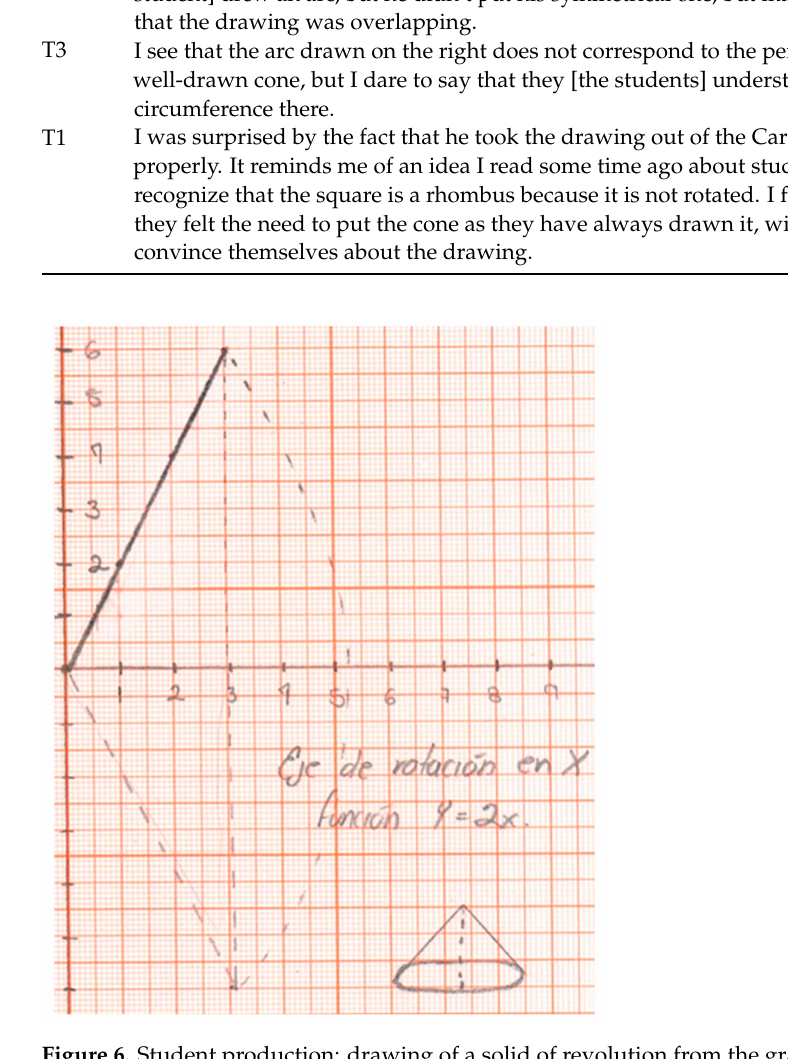
Figure 6. Student production: drawing of a solid of revolution from the graph of a segment. Note: Legend says: “Axis of rotation at x, function y = 2x